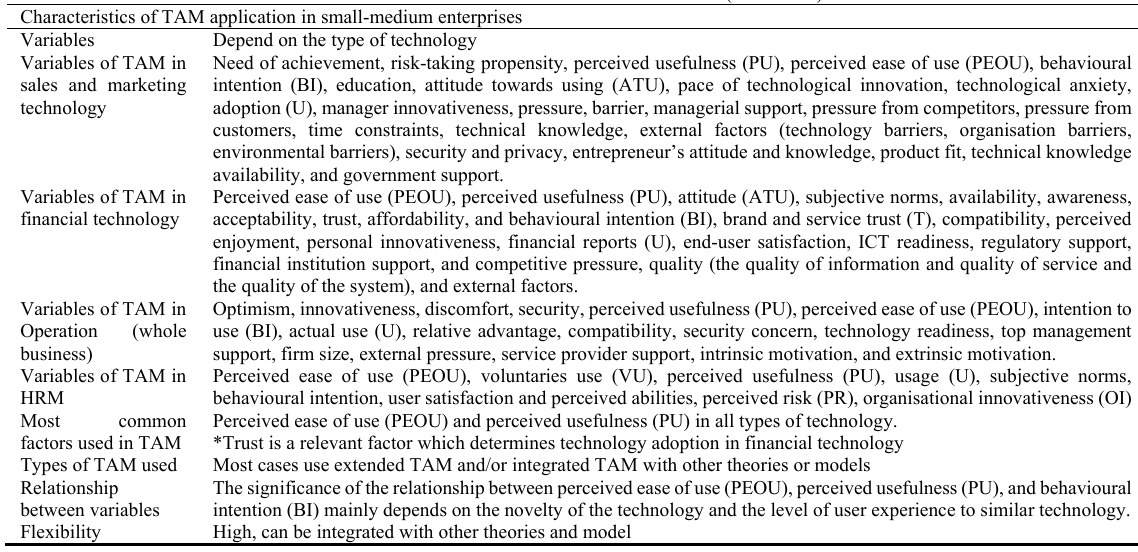
TABLE 4 C HARACTERISTICS OF TAM A PPLICATION IN SME